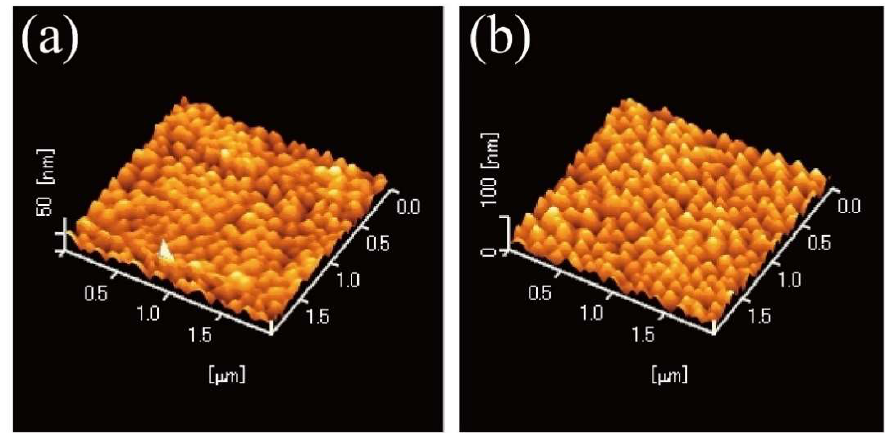
Figure 7. AFM topographical images of pentacene deposited on ( a ) RNA–CTMA and ( b ) DNA–CTMA film.